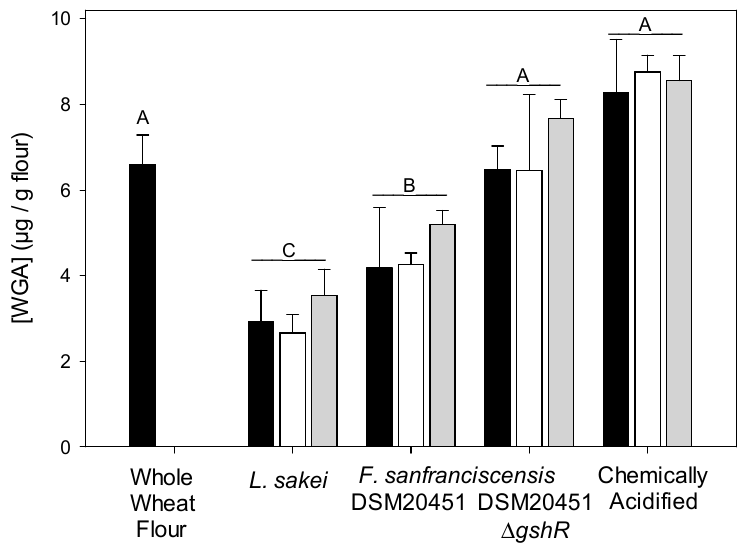
Figure 3. WGA content ( μ g WGA/g dry matter) of different sourdough samples ( n = 3 biological replicates) taken after 0.5 h (black bars) or 24 h (white bars) of fermentation, or after 24 h of fermentation with addition of protease from Aspergillus oryzae at 30 °C (gray bars). Unfermented flour was used as control. Samples fermented with different strains or different conditions differ significantly ( p < 0.001) unless they share a common capital letter. Samples fermented with the same strain for 0.5 h or for 24 h with or without addition of protease were not significantly different ( p > 0.05). The addition of protease resulted in a more liquid consistency of the doughs (data not shown), indicating degradation of gluten proteins, but did not reduce the WGA con- tent of sourdoughs ( p > 0.05). To verify whether oxidizing or reducing conditions affect WGA levels in dough, doughs prepared with flour from Red Fife but without addition of bacteria were analyzed by ELISA (Table 2). The addition of the oxidizing or reducing chemicals, hydrogen perox- ide and glutathione, respectively, did not change the WGA content of doughs ( p > 0.05) (Table 2), suggesting that biological reduction of oxidized glutathione acts differently from chemical oxidation or reduction of flour thiols. Table 2. WGA content of doughs prepared with whole wheat flour prepared with the wheat culti- var Red Fife.